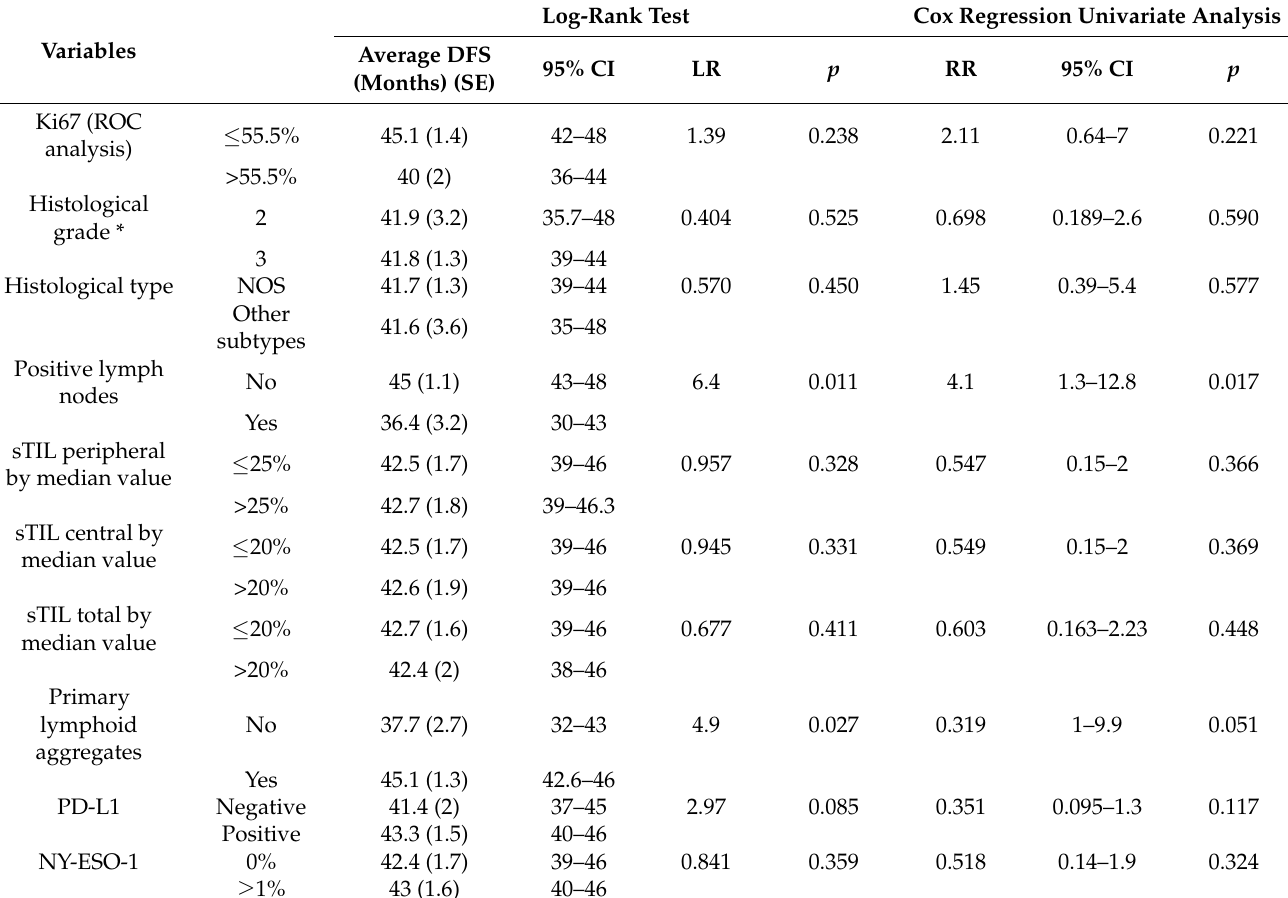
Table 3. Log-rank test and Cox regression univariate analysis for DFS in 97